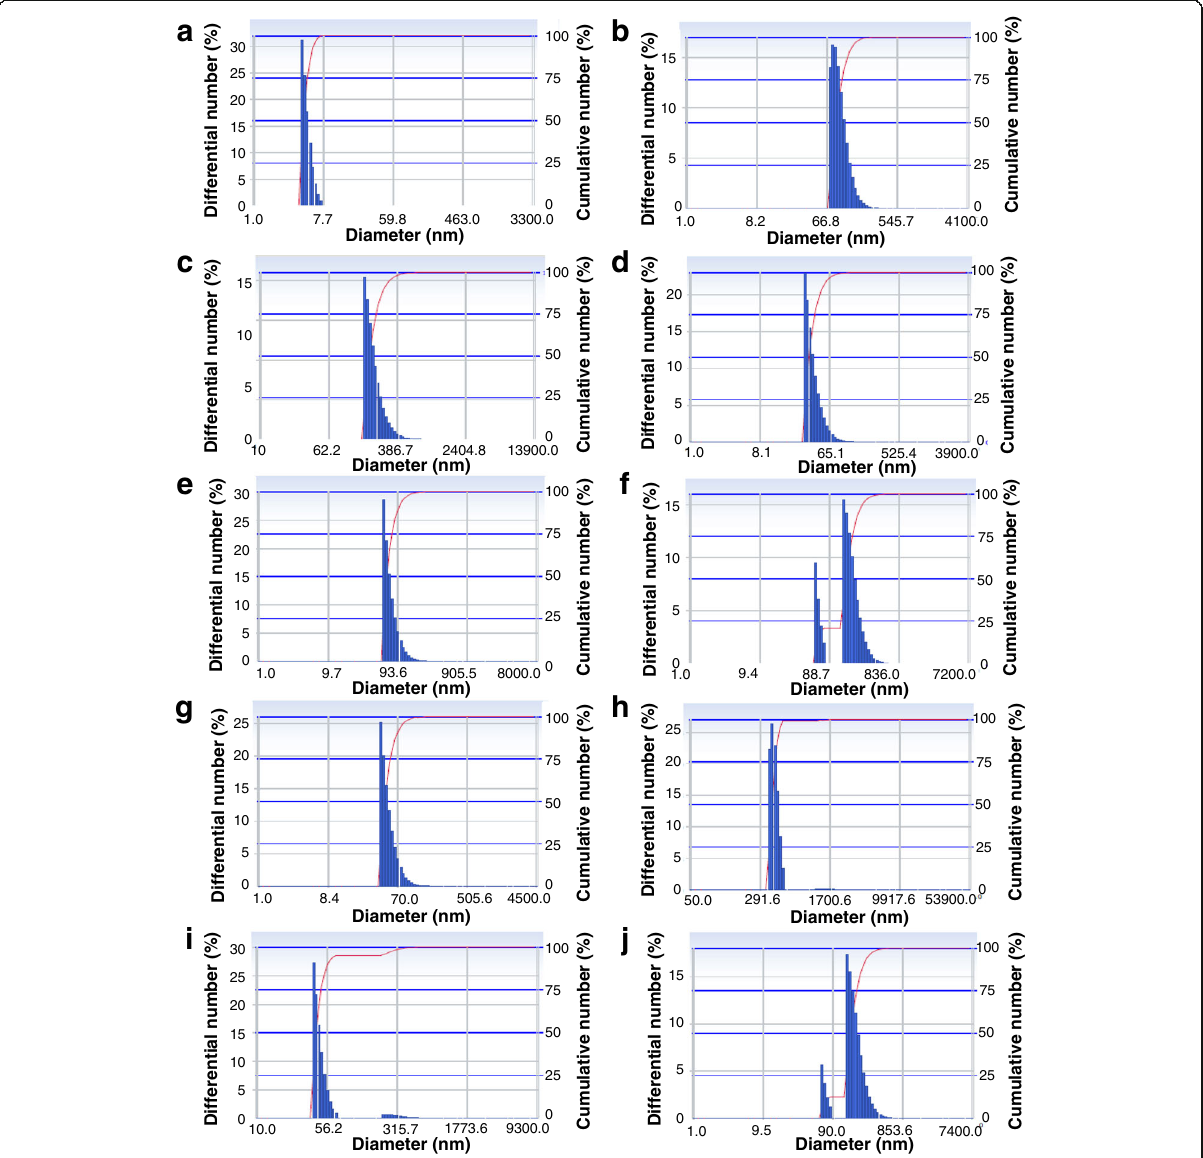
Fig. 3 DLS showing size distributions of the synthesized AuNPs a with × 1 cell-free filtrate, 1 mM HAuCl4 at 28 °C in dark, b under light, c with × 0.5 cell-free filtrate, d with × 2 cell-free filtrate, e at 0 °C, f at 15 °C, g at 75 °C, h at 100 °C, i with 0.5 mM HAuCl 4 and j with 2 mM HAuCl